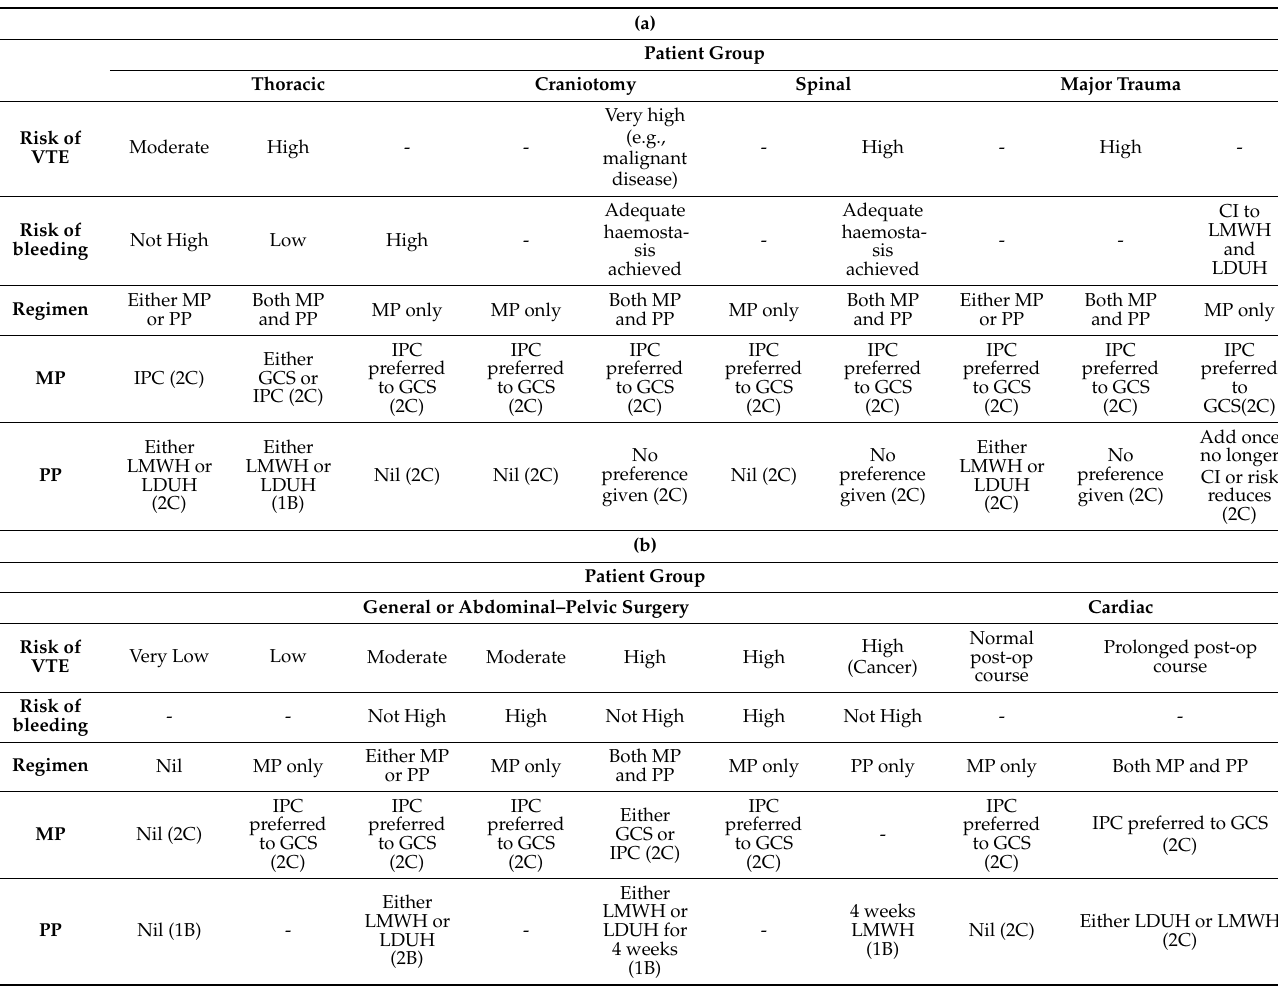
Table 2. A summary of current ACCP guidelines for non-orthopaedic surgery